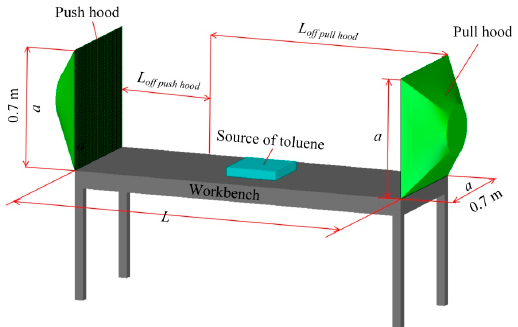
Figure 1. Geometric model of a push-pull ventilation system. a : side length of square hood, which is 0.7 m in this study, L : the distance between push hood and pull hood, L off push hood : the distance from push hood, L off pull hood : the distance from pull hood.